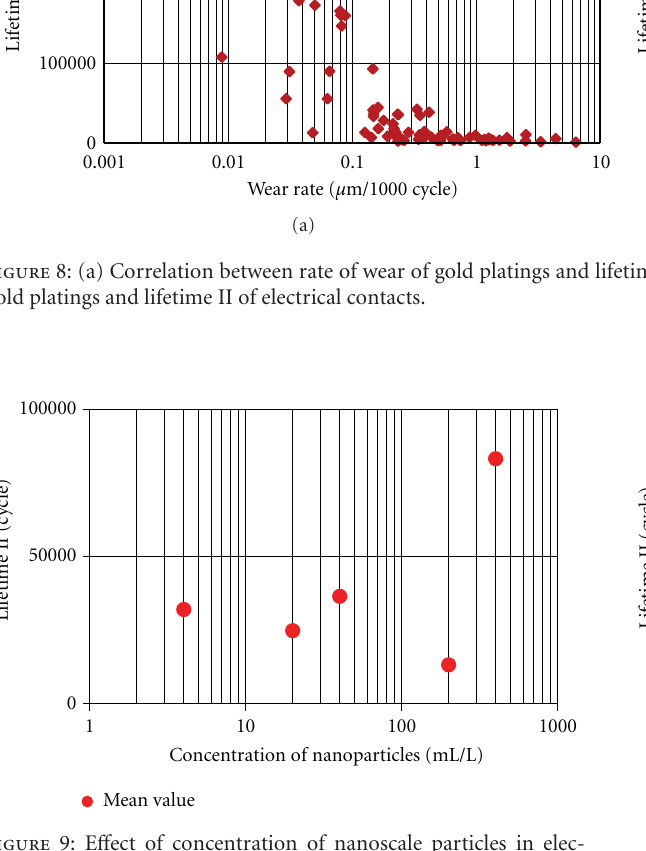
Figure 11: E ff ect of peak particle size in